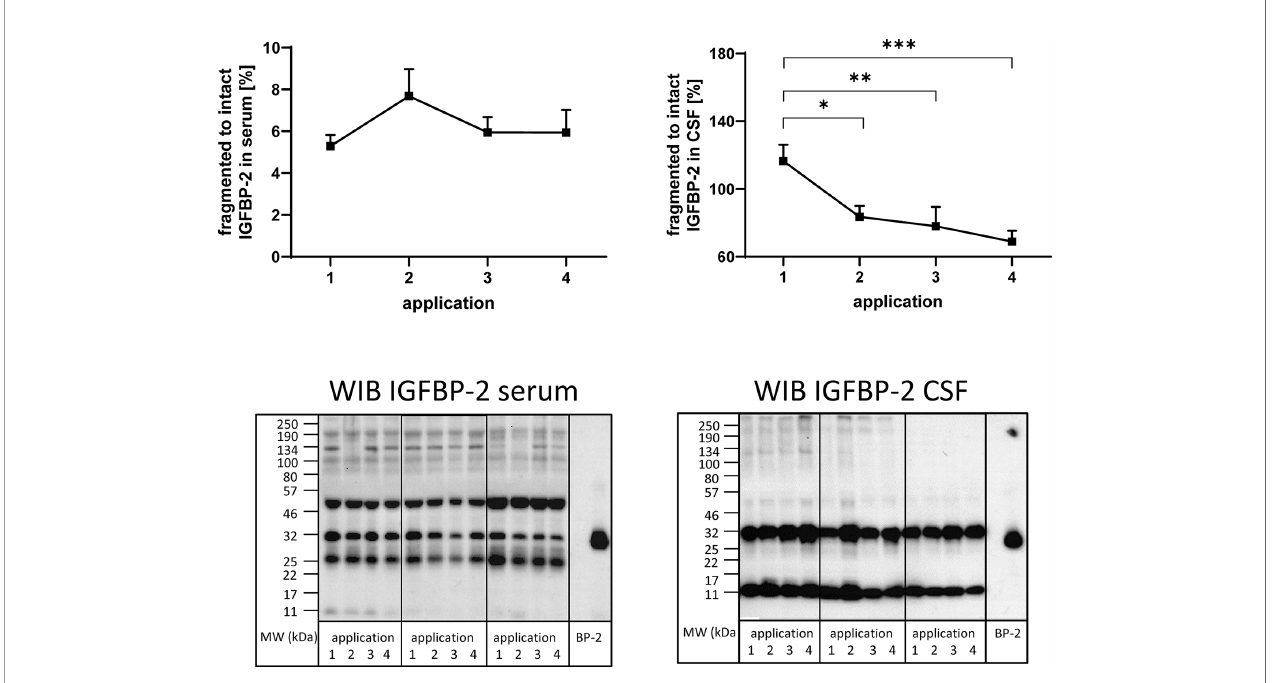
FIGURE 4 | Fragmentation of IGFBP-2 in serum (left panel) and CSF (right panel) from MS patients in the course of repeated intrathecal TCA injections. A subset of samples from 14 treatment cycles (nine cycles in four males and fi ve cycles in two females) was considered for this analysis. Fragmentation was calculated by the average ratio of fragmented (11 kDa) versus intact (32 kDa) IGFBP-2 and is presented in percentages (means ± SEM; signi fi cant differences are indicated; *p < 0.05; **p < 0.01; ***p < 0.001). On the lower panels examples for the Western immuno blot (WIB) are provided for the analysis of serum and CSF. All samples from a treatment cycles I to IV were loaded on the same gel and recombinant human IGFBP-2 (BP-2) was loaded as the positive